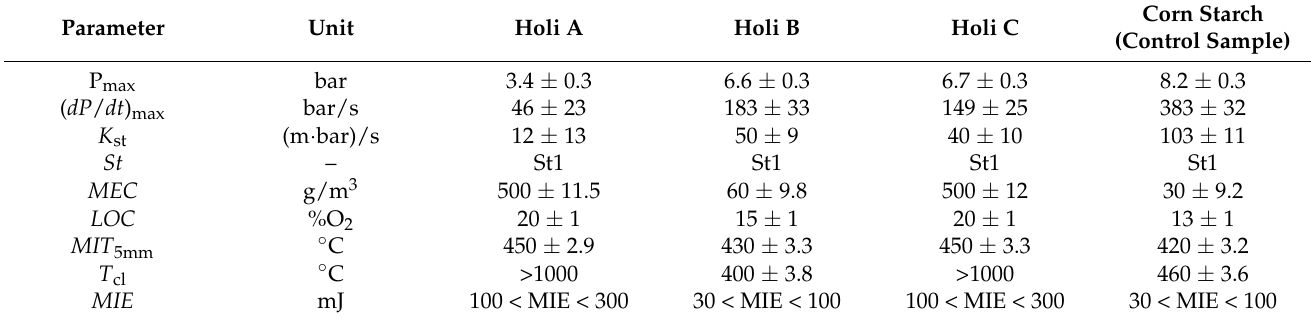
Table 5. Comparison of flammability and explosiveness of the Holi and corn starch dusts analyzed [7–14].